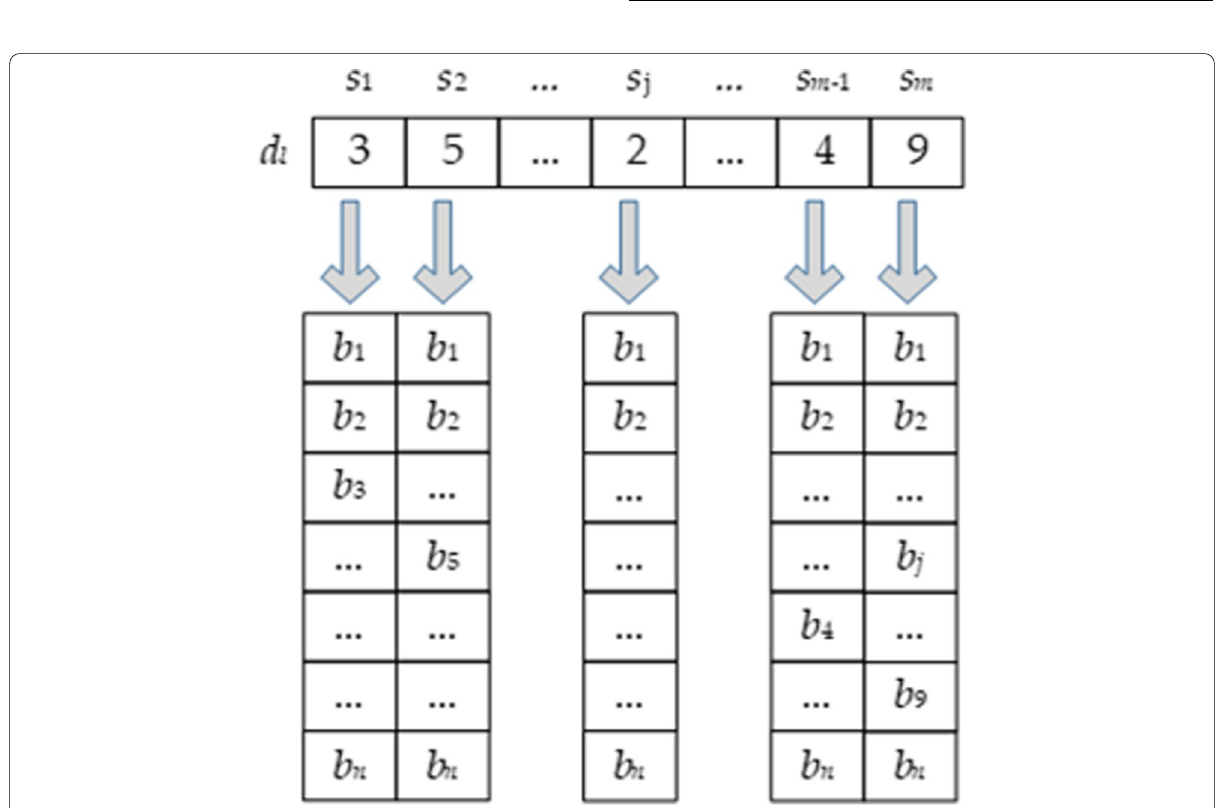
Fig. 5 Example of the coding of individual fruit